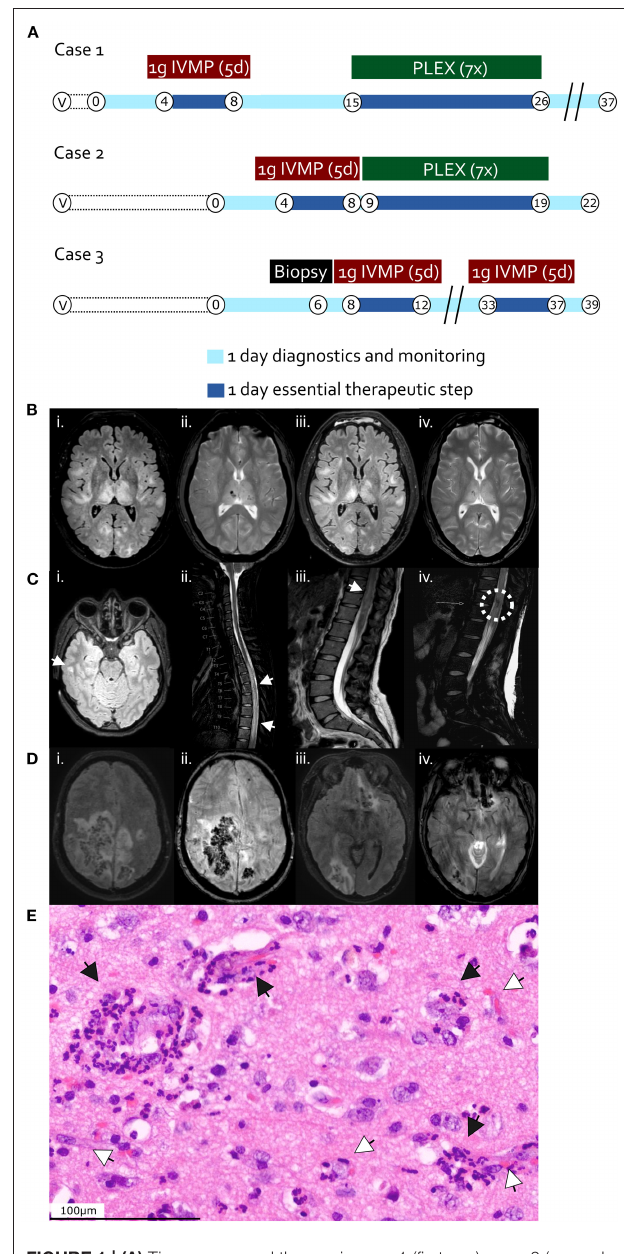
FIGURE 1 | (A) Time course and therapy in case 1 (first row), case 2 (second row), and case 3 (third row). “V”, vaccination timepoint; “B”, Biopsy and hemicraniectomy timepoint in case 3; “IVMP”, intravenous methylprednisolone; “PLEX”, Plasma exchange. Encircled numbers indicate days after admission. (B–D) Magnetic resonance imaging (MRI) findings. (B) Case 1, day 2 after admission; brain axial T2 FLAIR (i) and T2 haem-sensitive sequence (ii); follow-up brain MRI at day 7 after admission, after methylprednisolone pulse regimen; brain axial T2 FLAIR (iii) and T2 haem-sensitive sequence (iv). (C) Case 2, day 1 after admission; brain axial T2-FLAIR (i); sagittal cervico-thoracic spinal T2 (ii); sagittal thoraco-lumbar spinal T2 (iii, iv). White arrowheads indicate FLAIR-hyperintense lesions (i–iii), the dashed white circle in iv highlights a region of spinal hemorrhage. (D) Case 3, day 2 after admission; brain axial T2 FLAIR (i, iii) and SWI (ii, iv) sequences. (E) Hematoxylin and eosin-stained section from right temporal cortical biopsy of case 3 (day 6), displaying perivascular immune cell infiltrates including neutrophilic granulocytes (black arrow heads), tissue edema, and perivascular hemorrhage (white arrow heads). Scale bar 100 µ